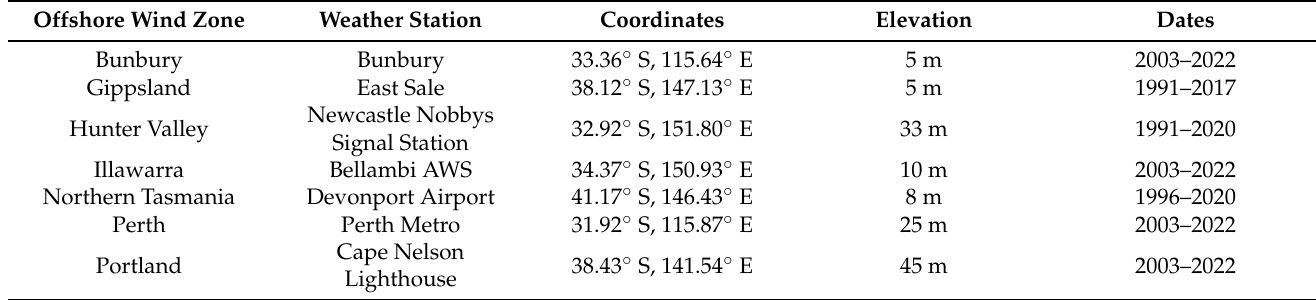
Table 2. Bureau of Meteorology weather station used for assessing wind speed predictions